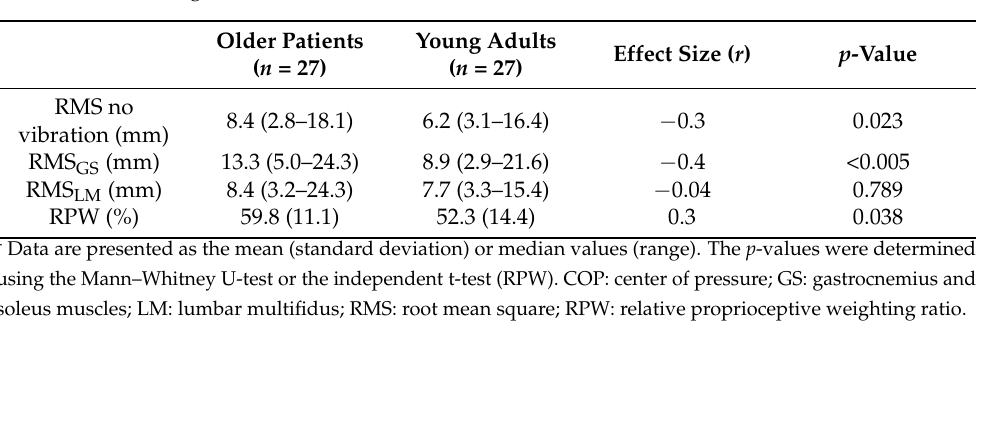
Table 2. Displacement of the COP during local vibratory stimulation in young adults and